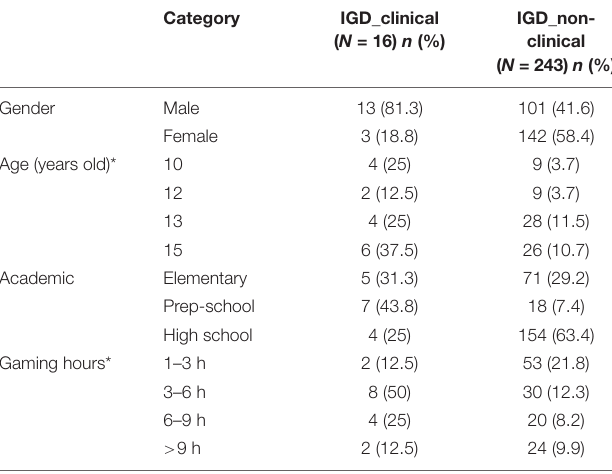
TABLE 4 | Means, standard deviations, and t -test for equality of means of IGD.Total according to gender.